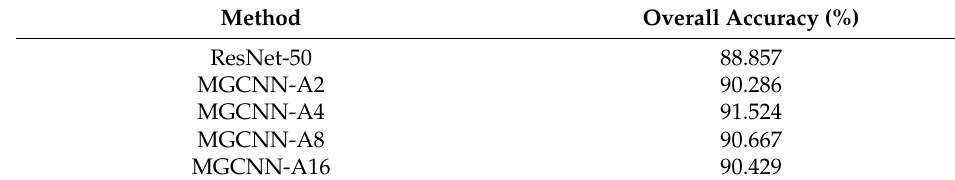
Table 7. Overall accuracy (OA) achieved by the MGCNN-A with UC-Merced dataset.